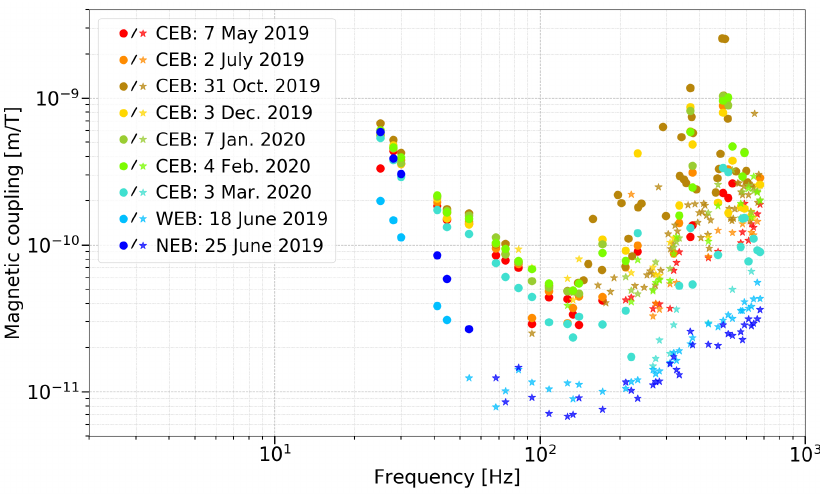
Figure 6. Magnetic coupling functions for CEB, WEB, and NEB. For CEB multiple injections over the time of O3 are shown to illustrate the time variations. Dots are measured values of the magnetic coupling, while stars are upper-limits, calculated using Equation (2).